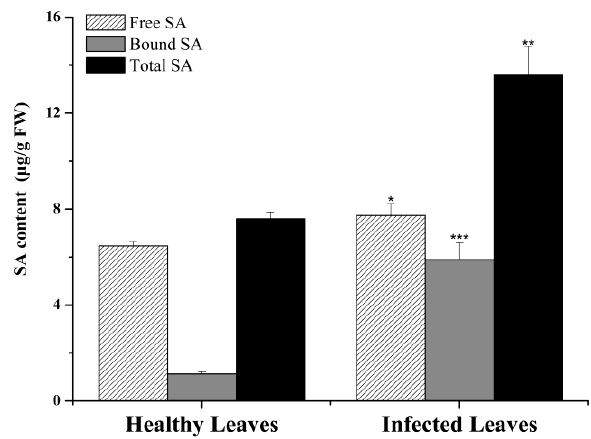
Figure 7. Salicylic acid (SA) content determined by high-performance liquid chromatography (HPLC) in LJ43. All HPLC experiments were performed in triplicate ( n = 3). Data are represented as means ± SD. Compared with related healthy leaves, * means p < 0.05, ** means p < 0.01 and *** means p < 0.001.